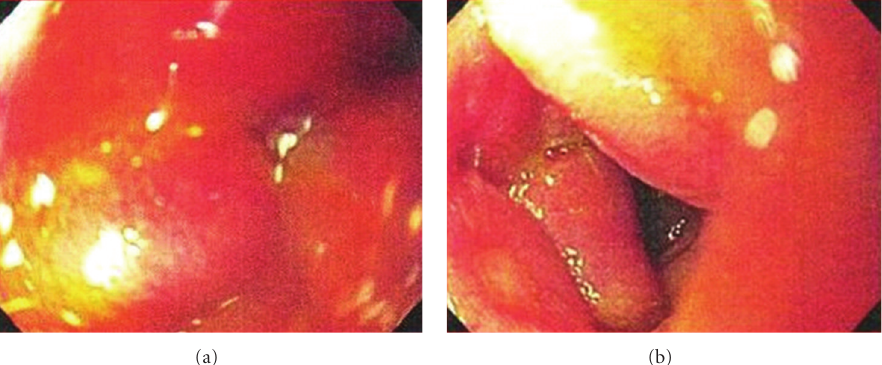
Figure 2: Esophagogastroduodenoscopy image on the left shows edematous and eythematous mucosa of the 3rd portion of the duodenum. Image on the right shows an area of 5mm of ulceration in the 4th portion of the duodenum.